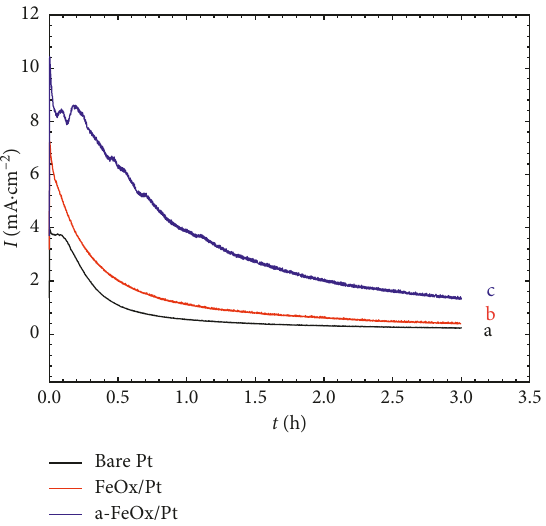
Figure 6: Current transients (I-t) obtained at 0.2V during FAO at bare Pt (a), FeOx/Pt (b), and a-FeOx/Pt ( − 0.5 V) (c) electrodes.